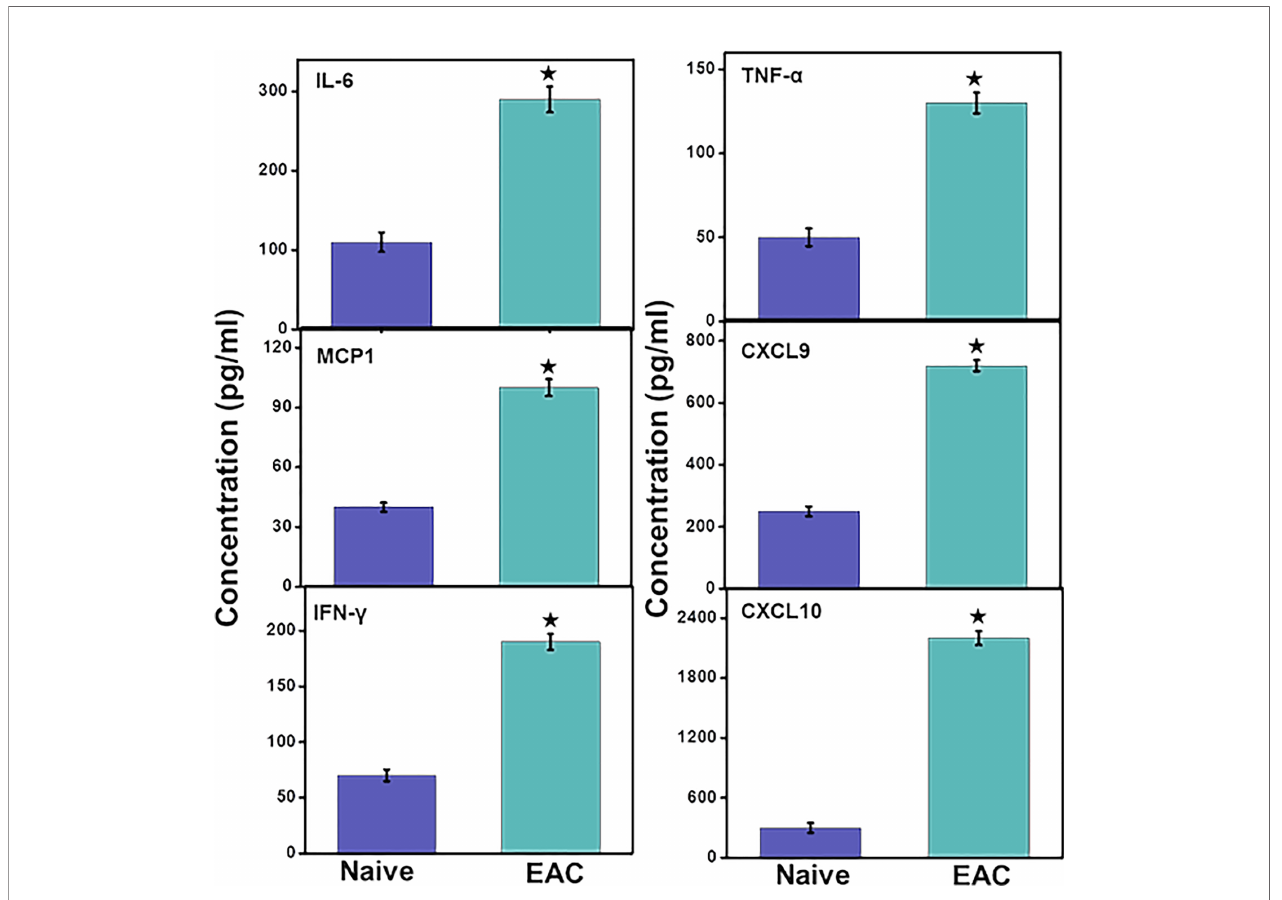
FIGURE 5 | IC induction induces levels of systemic pro-in fl ammatory and in fl ammatory cytokines and chemokines. After mice were sacri fi ced, serum levels of IL-6, MCP-1, CXCL9, CXCL10, TNF- a and IFN- g were determined by a Bio-Rad ELISA multiplex kit capable of detecting >10 pg/ml of these analytes. The data presented are the cumulative mean concentrations of these cytokines ± in three separate experiments. Asterisks (*) indicate statistically signi fi cant differences (p < 0.01) between IC and naïve control